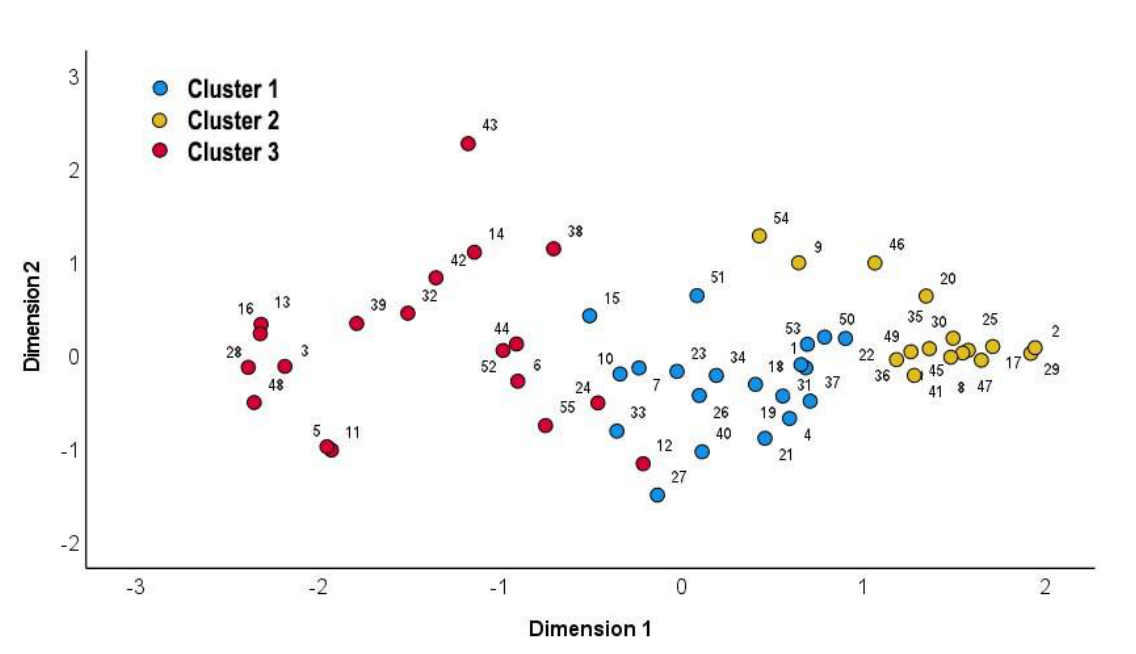
Figure 2. Three unique needs profiles of the final three-cluster solution based on the mean scores for each need item in the Family Needs Survey.